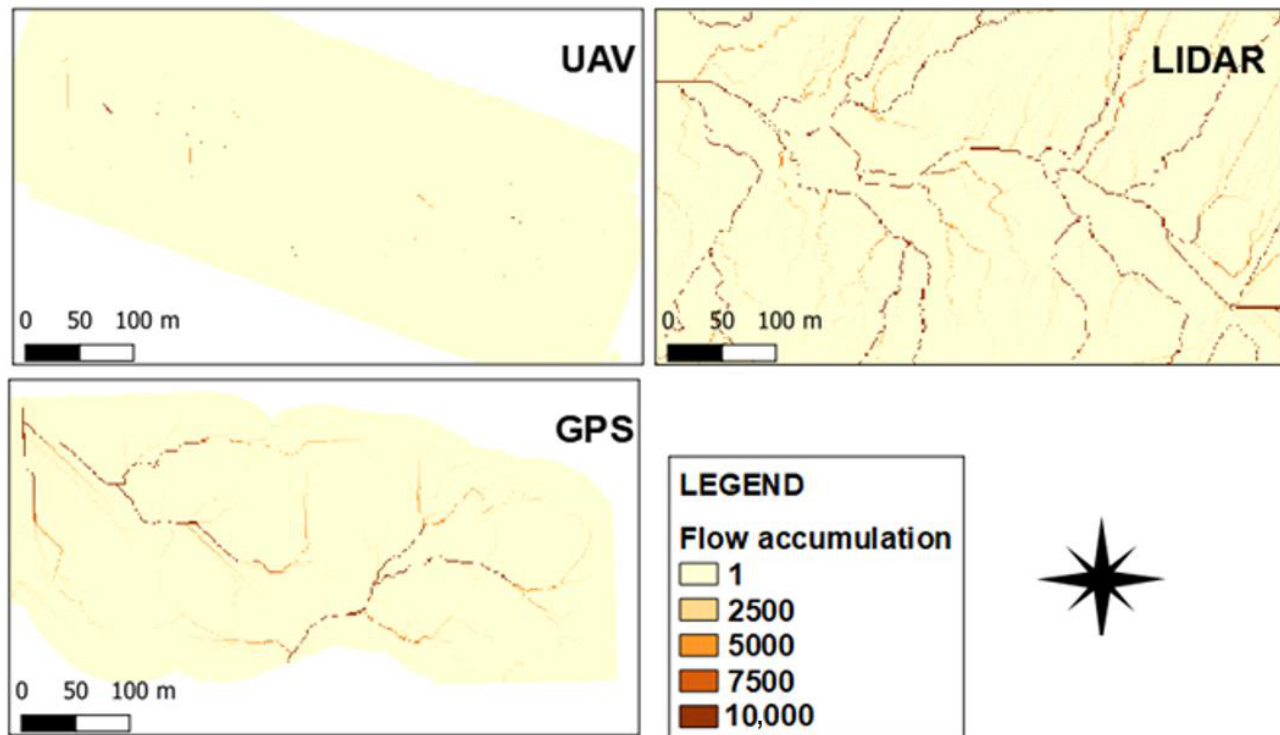
Figure 8. Flow accumulation map generated from DEM created based on surveying data by pho- togrammetric methods using UAV, LIDAR and GNSS/RTN; source: own